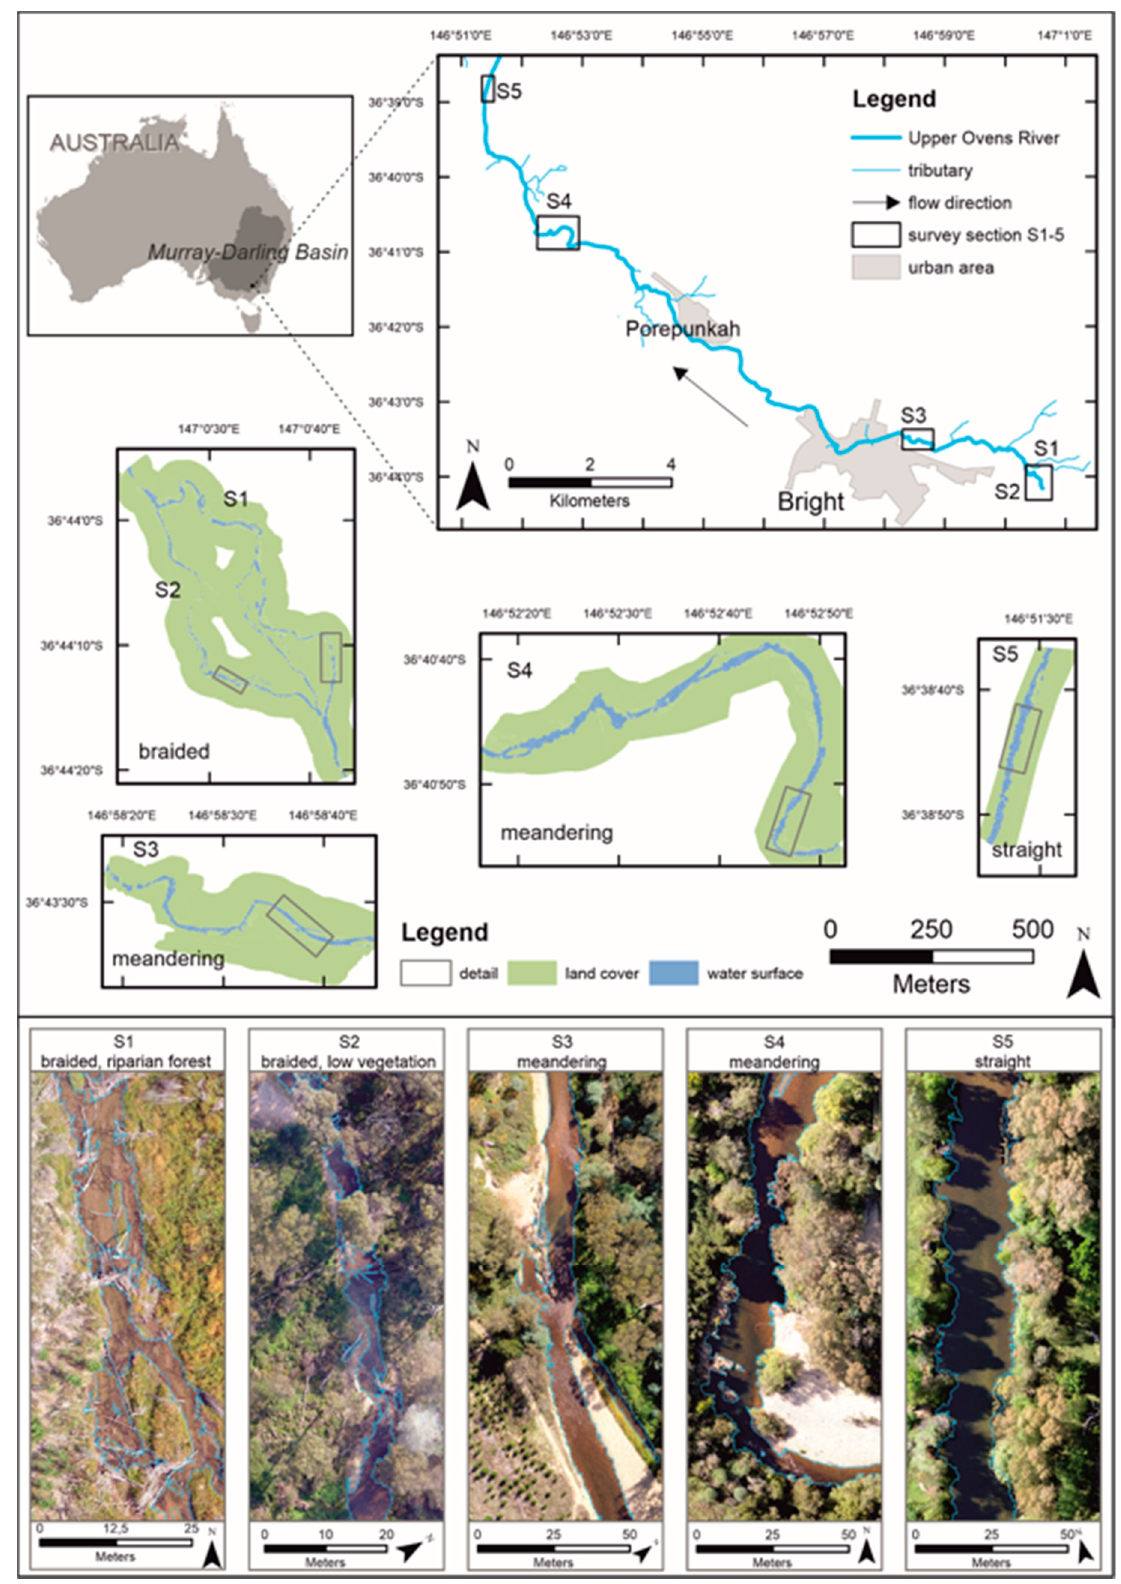
Figure 1. Location of the Upper Ovens River and the survey sections 1–5 (top), and detailed red–green–blue-band (RGB) imagery of a representative stretch for each survey section, including the water area’s delimitation (bottom).